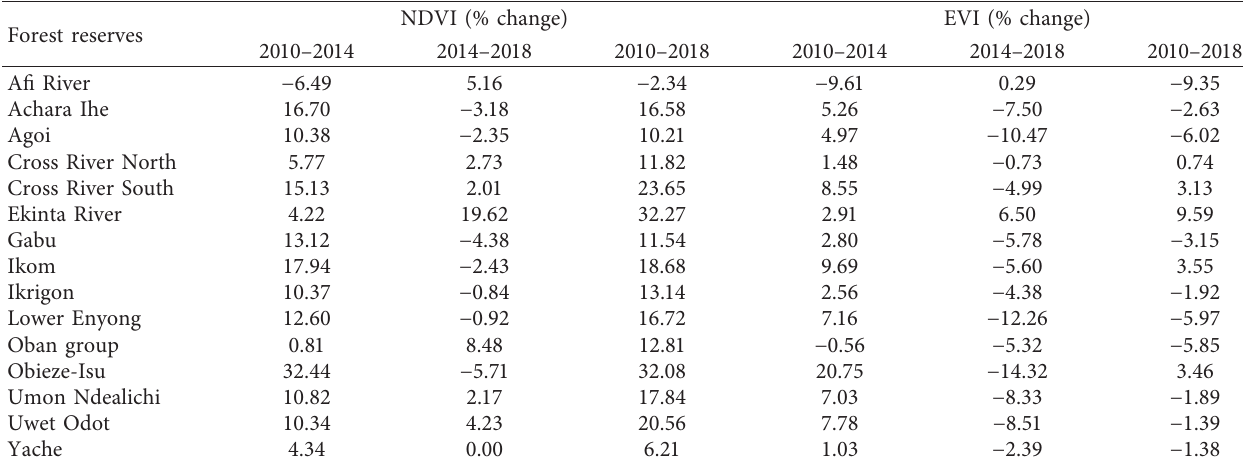
Table 4: Percentage change of vegetation